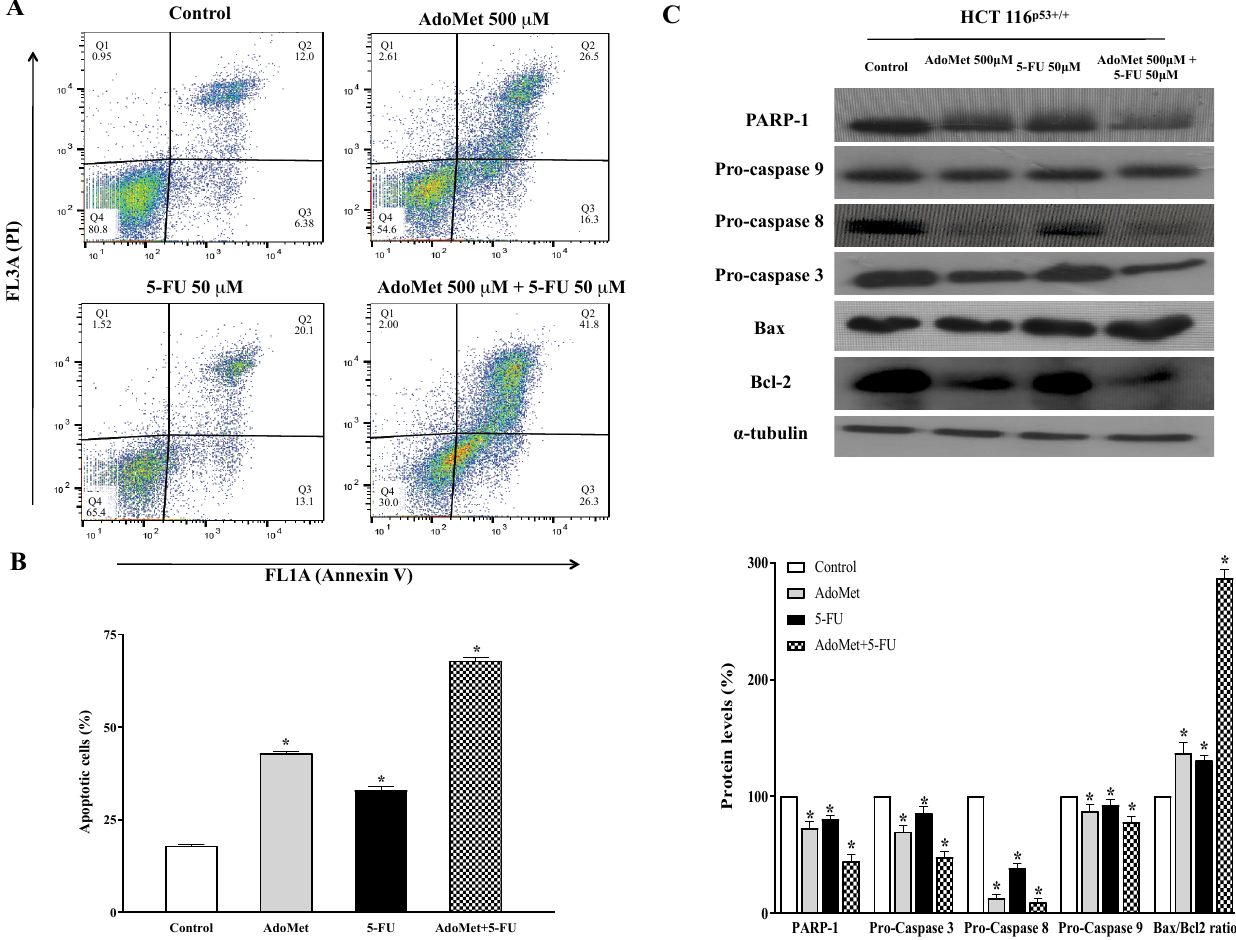
Figure 2. Effect of AdoMet, 5-FU and their combination on apoptosis in HCT 116 p53+/+ cells. ( A ) Cells were treated with 5-FU 50 µ M for 24 h with and without 48 h pretreatment with 500 µ M AdoMet. Apoptosis was then evaluated by FACS analysis. Representative dot plots of both Annexin V-FITC and PI-stained cells. The different quadrants show the percentage of cells: viable cells, lower left (Q4); early apoptotic cells, bottom right (Q3); late apoptotic cells, top right (Q2); nonviable necrotic cells, upper left (Q1). For each sample, 2 × 10 4 events were acquired. Analysis was carried out by triplicate determination of at least 3 separate experiments. ( B ) The histogram plot shows, for each single treatment, the percentage of apoptotic cells in the Q2 and Q3 quadrants. Data represent the average of three independent experiments. ( C ) The protein levels of PARP-1, pro-caspase 9, pro-caspase 8, pro-caspase 3, Bax, and Bcl-2 were detected by Western blot analysis using the total cell lysates. The house-keeping protein α -tubulin was used as loading control. The graph reports the relative densitometric analyses expressed as percentage of untreated control (100%). Error bars represent the standard deviation. * p < 0.05 versus untreated cells. The images are representative of three immunoblotting analyses obtained from three independent experiments. Full-length blots are shown in Figure